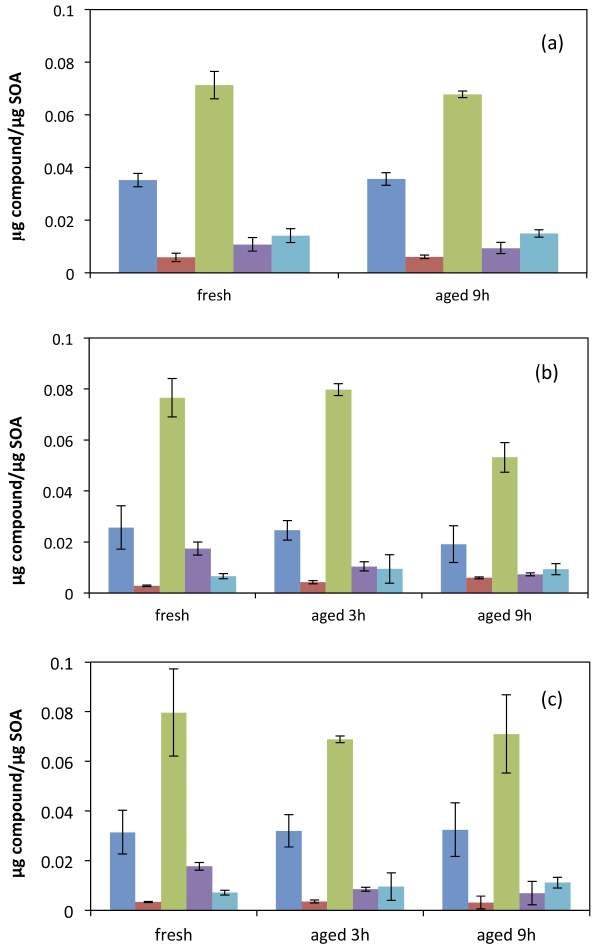
Figure 7. Normalized concentrations (µgµg − 1 SOA) of terpenylic acid (dark blue), MBTCA (red), pinic acid (light green), pinonic acid (violet), and a dimer MW 358 (light blue) at three aging condi- tions: (a) dark aging with exposure to residual ozone, (b) OH radical initiated aging and (c) UV-only aging experiments. Pinic, pinonic and terpenylic acids represent organic species associated with fresh SOA, whereas MBTCA is associated with aged SOA. The peak ar- eas for all four dimers, determined by LC/MS, showed relatively good linear fit with R 2 >0.90 suggesting that these compounds are formed through similar processes. To avoid overloading the figure, only one, the most commonly observed dimer with MW 358 in both ambient and laboratory-generated OA, is shown in the